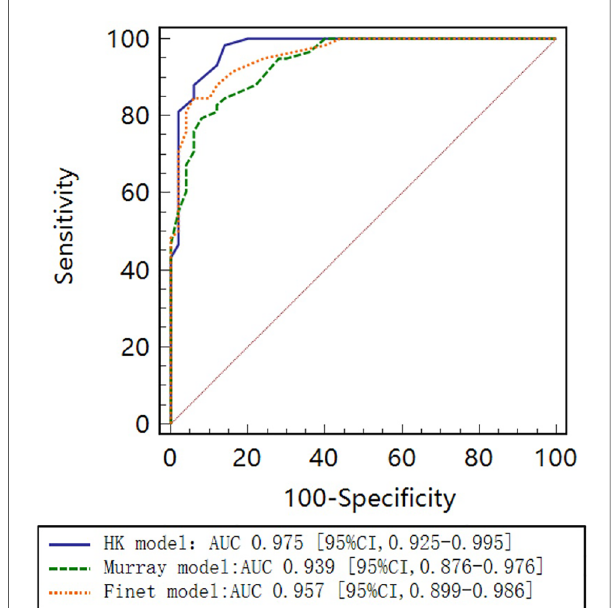
FIGURE 11 Receiver operating characteristic (ROC) curves for diagnosis of physiologically signi fi cant stenosis. HK model shows higher diagnostic accuracy than Finet model and Murray